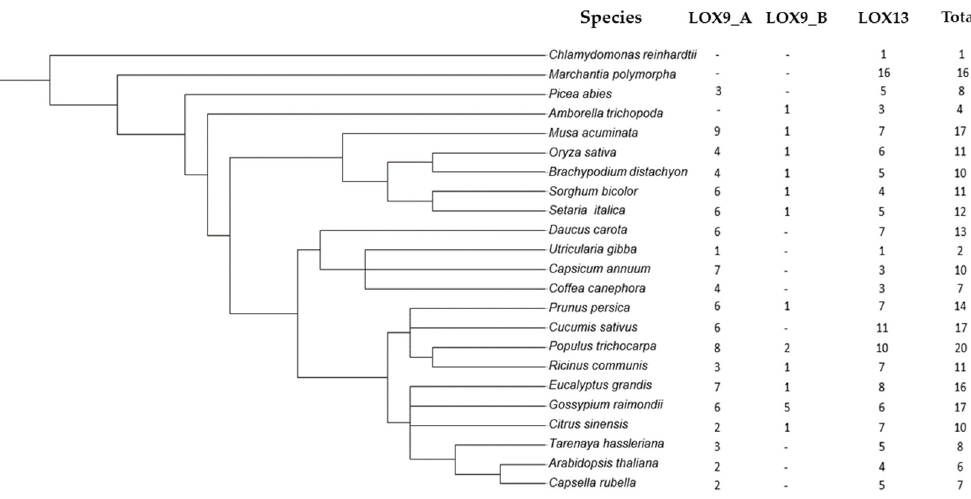
Figure 1. Number of LOX genes distributed among angiosperm groups. Fourteen species of eudicots, five species of monocots, and four basal species were